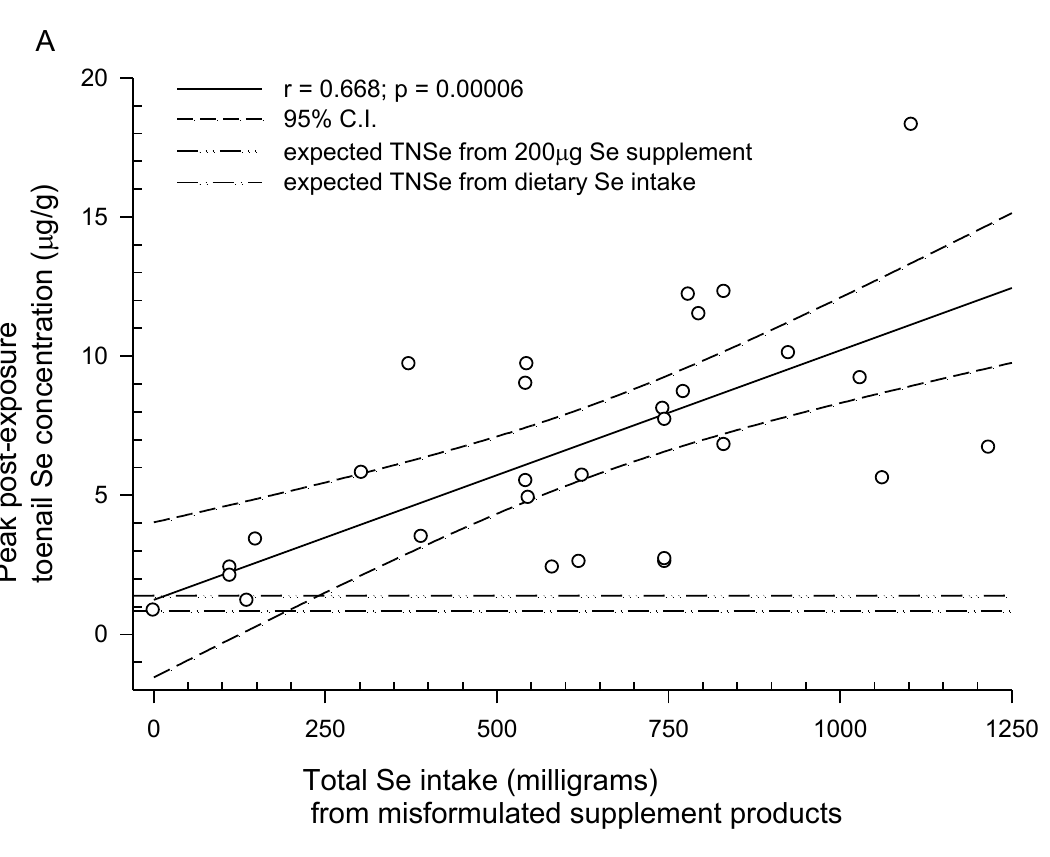
Figure 2. Dose responses measured in the toenail biologic monitor relating peak ( A )